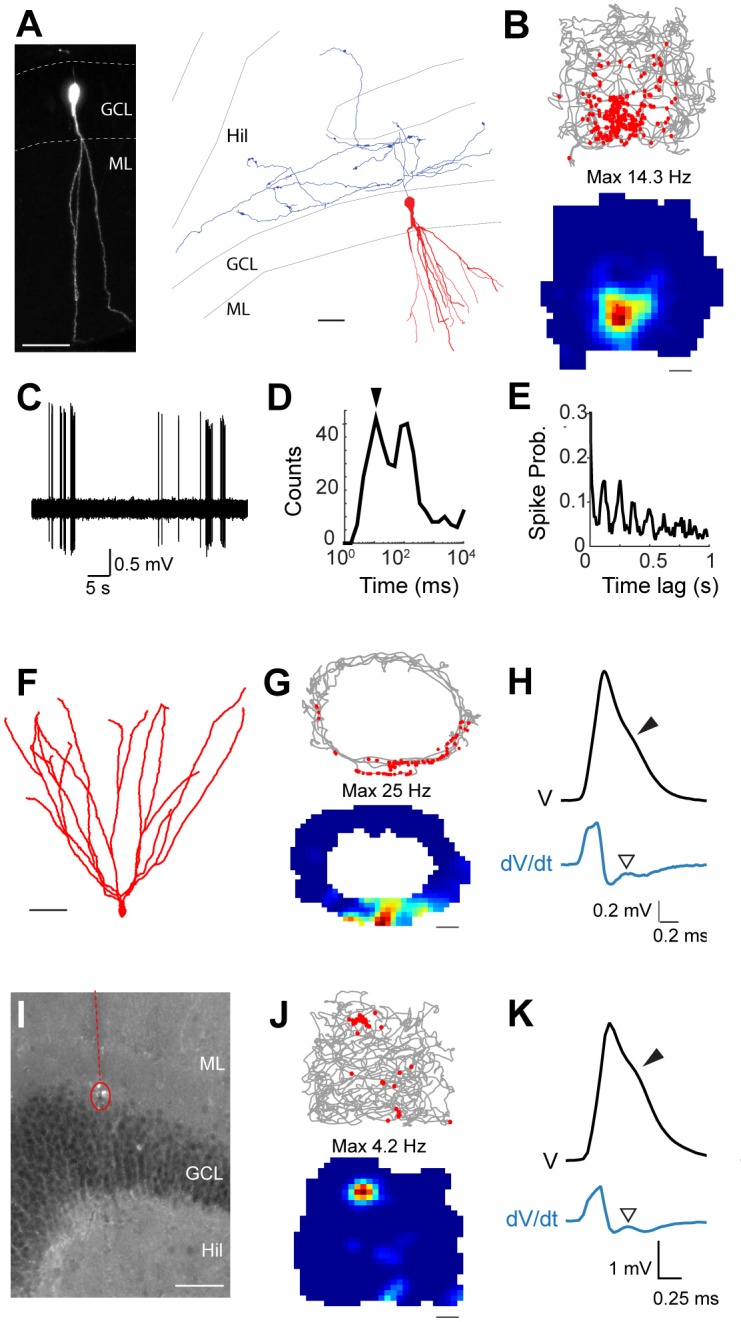
Spatial and temporal firing properties of identified active granule cells.(A) Left, single-plane confocal image showing a morphologically mature GC (cell id 103) located in the infrapyramidal blade, recorded and labeled in a freely moving animal. Right, reconstruction of dendritic (red) and axonal (blue) morphologies; only the axon extending within the hilus (Hil) is shown. Close anatomical proximity (< 1 µm; compatible with putative synaptic contacts) was observed between mossy boutons and large hilar neurons (4 out of 13 analyzed boutons; not shown), suggesting that hilar neurons might integrate spatial signals from upstream GCs. Scale bars=50 μm. GCL=granule cell layer; ML=molecular layer. (B) Spike-trajectory plot (top) and rate map (bottom) for the neuron shown in (A), recorded in a square arena. Scale bar=10 cm. (C) Representative high-pass filtered spike trace, recorded during free behavior from the neuron in (A). (D) Interspike interval (ISI) distribution for the neuron in (A). Note the early peak (arrowhead) representing short ISI within bursts. (E) Spike-autocorrelogram for the neuron in (A). Note the prominent rhythmicity in the theta-frequency range (~8 Hz during awake behavior). (F) Reconstruction of the dendritic morphology of an active morphologically mature GC (cell id 104) recorded during freely moving behavior. Scale bar=50 µm. (G) Spike-trajectory plot (top) and rate map (bottom) for the neuron shown in (F) recorded on an O-shaped linear arena. Scale bar=10 cm. (H) Normalized average spike waveform (black) of the neuron shown in (F), with corresponding first derivative (blue). Black arrowhead indicates the spike-shoulder and white arrowhead the local peak in the first derivative. The first derivative is scaled up for illustration purposes. (I) Fluorescence micrograph showing a histologically verified electrode track (red dotted line) and recordings site (dotted circle), which was localized to the superficial portion of the GC layer (end of the track). Note the presence of small cell debris at the labeling site (dotted circle). (J) Spike-trajectory plot (top) and rate map (bottom) for the recording location shown in (I) (putative GC recording, cell id 80) during exploration of a square open arena. Scale bar= 10 cm. (K) Same as in (H), but for the putative GC recording in (I).